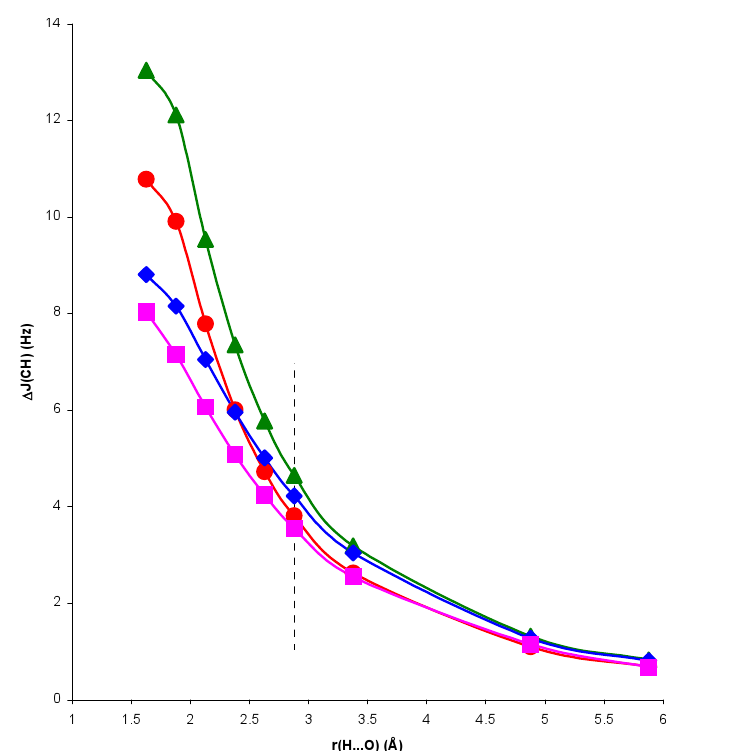
Figure 6. Complex and electric field changes in 1 J(CH) for the CH rspectively, at every optimized geometry, with respect to 1 J(CH) for the isolated CH function of the H...O distance, r(H...O). - (cid:88) - ∆ J EG (RPA), - (cid:81) - ∆ J EG (SOPPA), - (cid:86) - ∆ J CG (RPA), - (cid:79) - ∆ J CG (SOPPA). The dotted line indicates the equilibrium